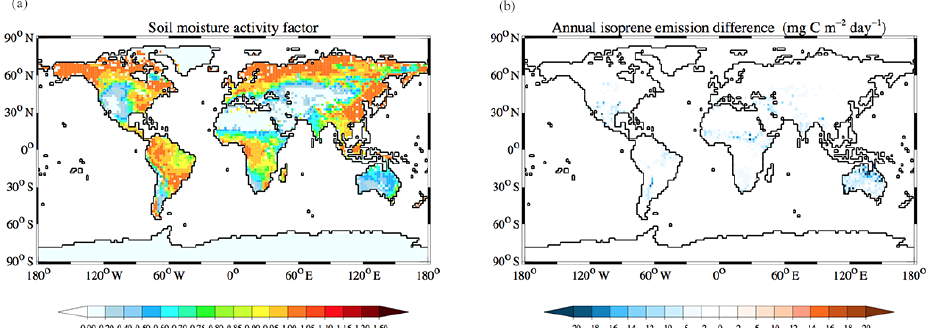
Figure 11. (a) Annual soil moisture activity factor averaged over the simulation period, and (b) annual isoprene emission differences (TEST- SM minus reference simulation) (TgCyr − 1 ).